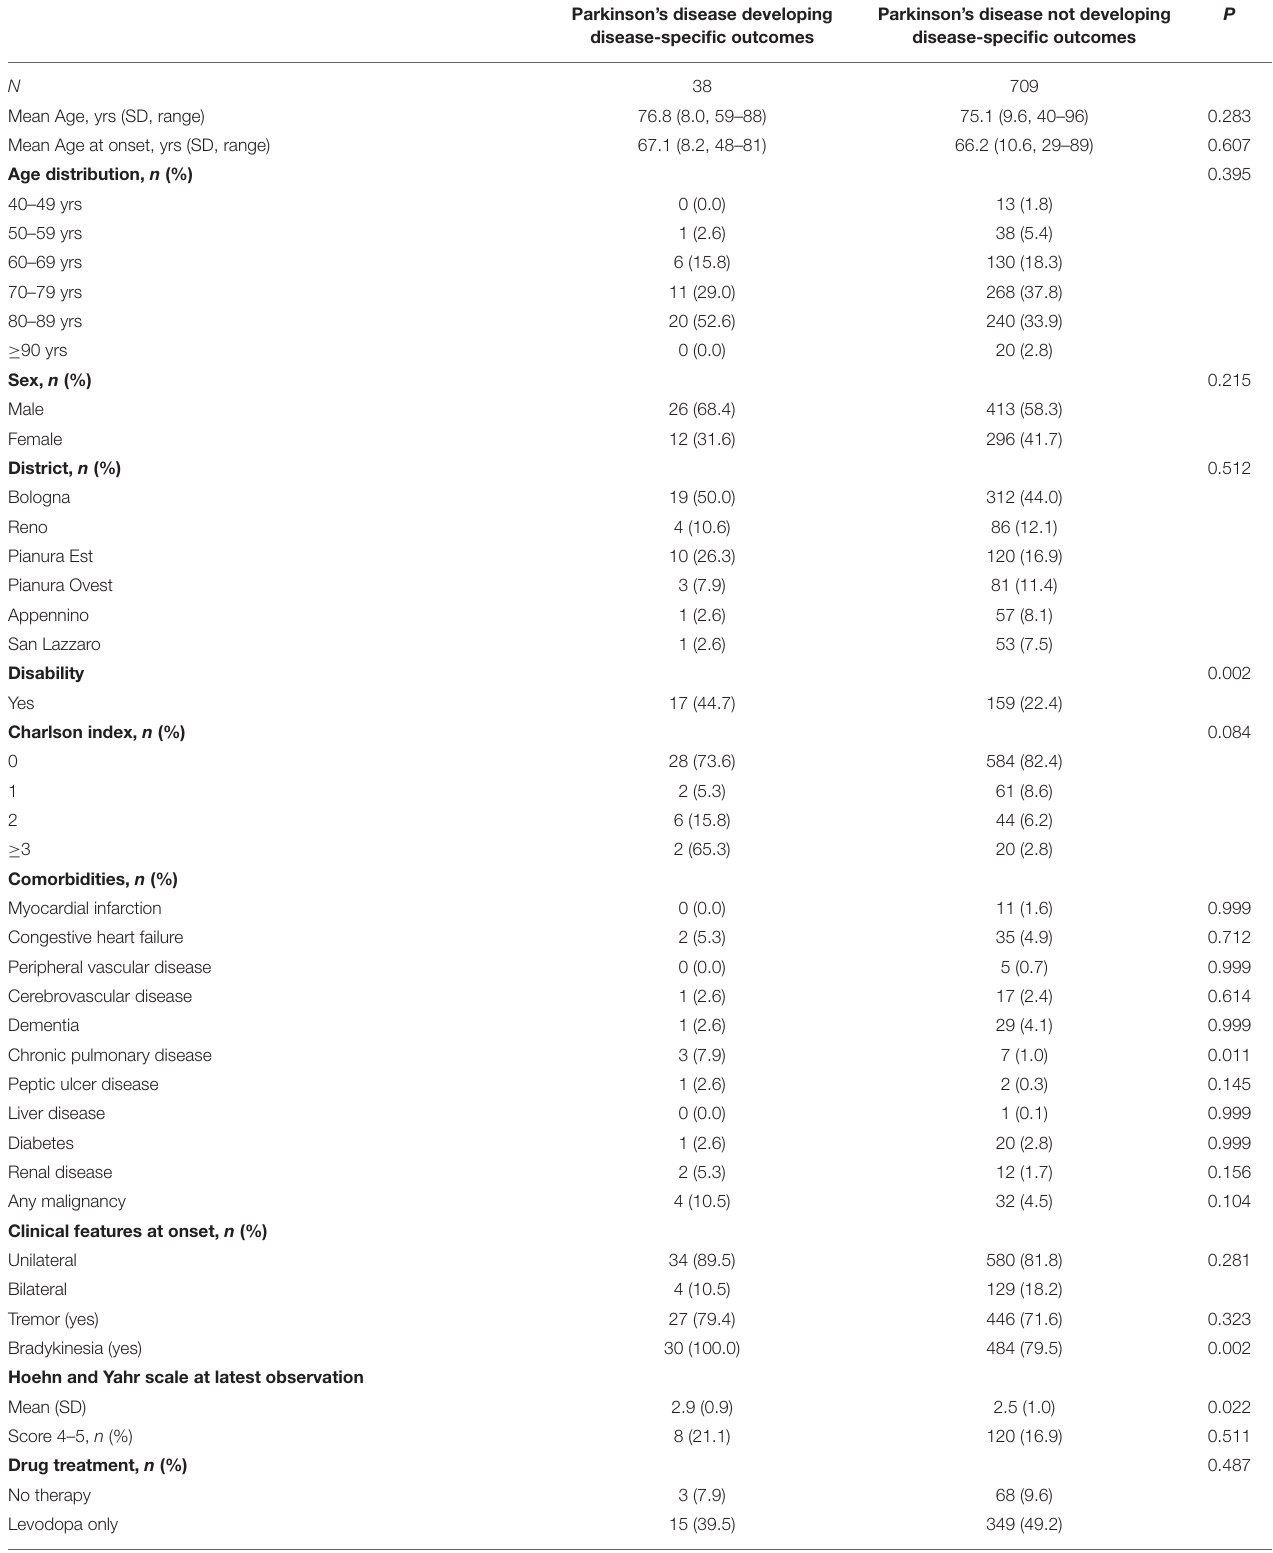
TABLE 5 | Prognostic analysis in Parkinson’s disease cohort, period June-September 2020.